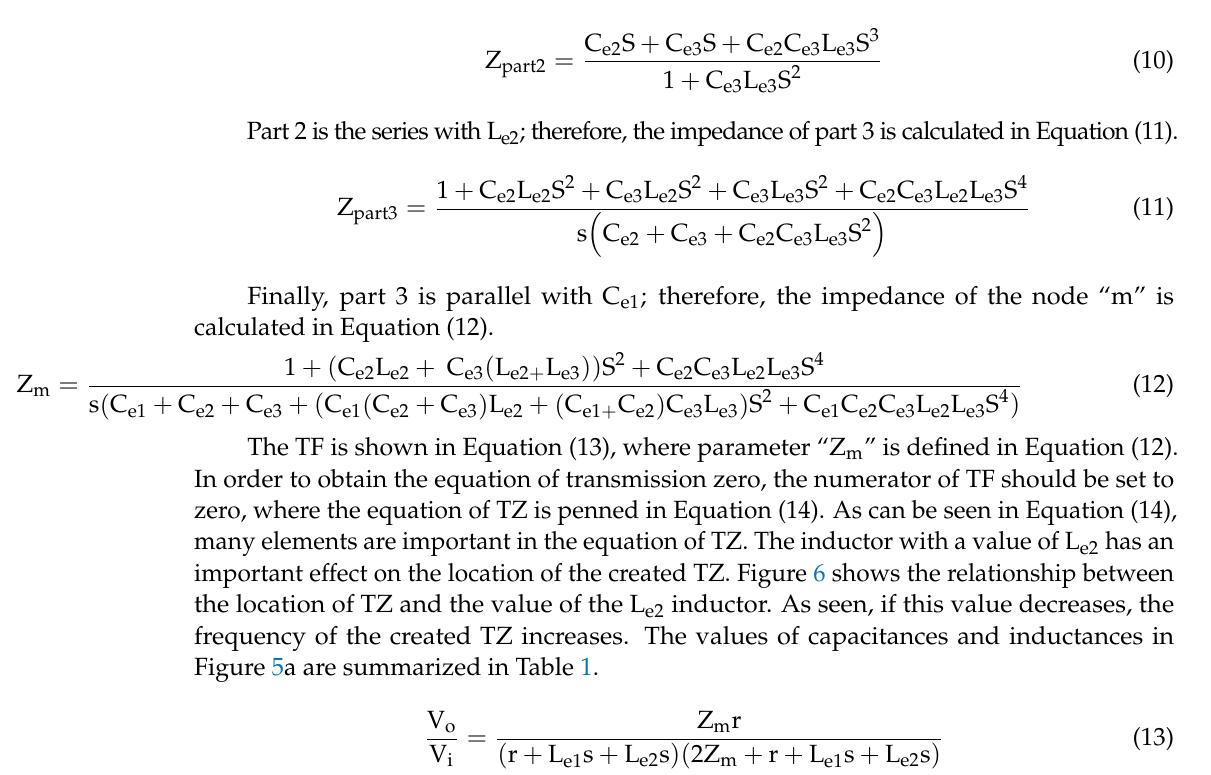
Table 1. The obtained values of capacitances and inductances.